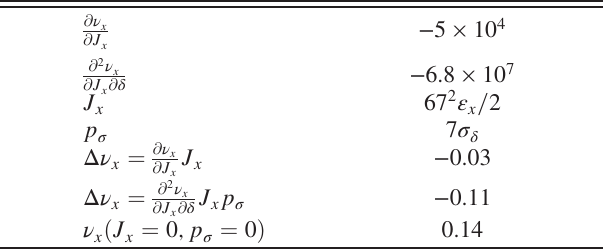
TABLE IV. Tune shift contribution from detuning and detuning chromaticity.